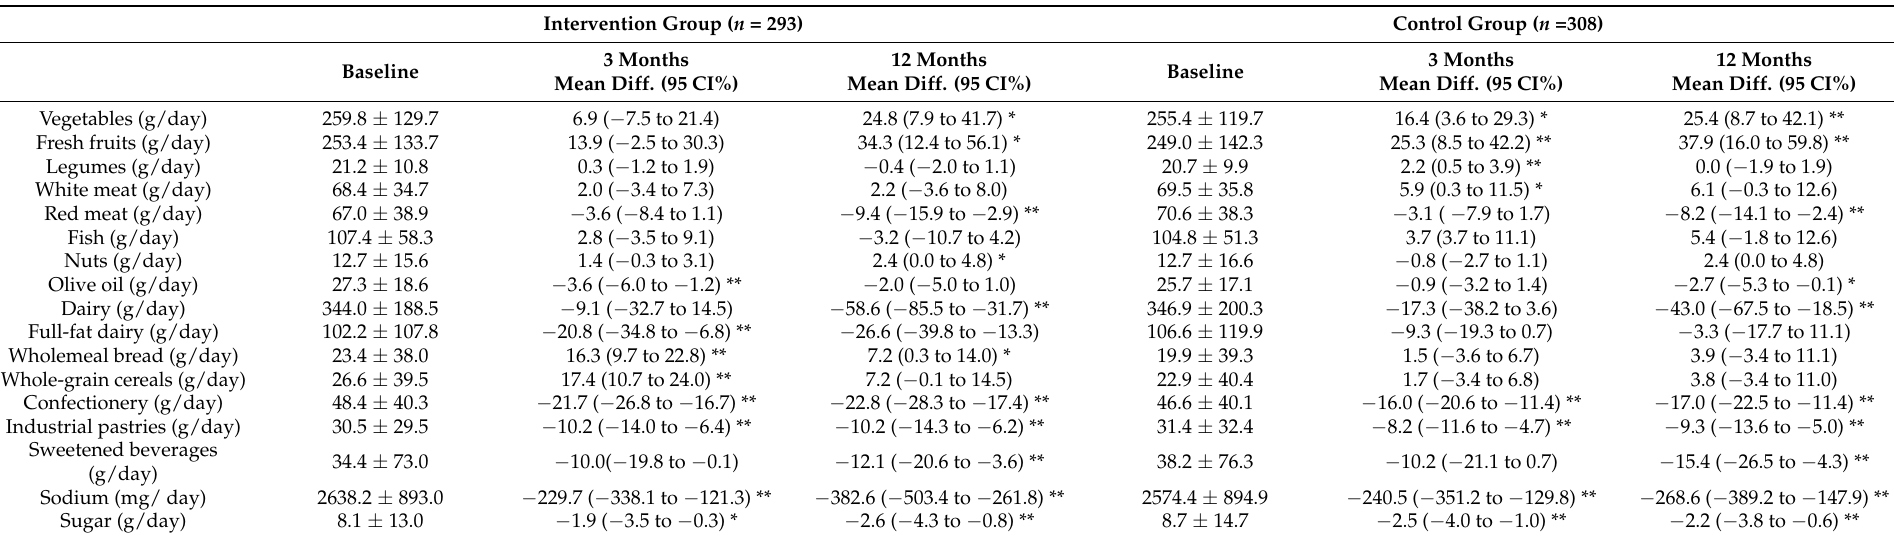
Table 4. Changes in the intake of food groups throughout the